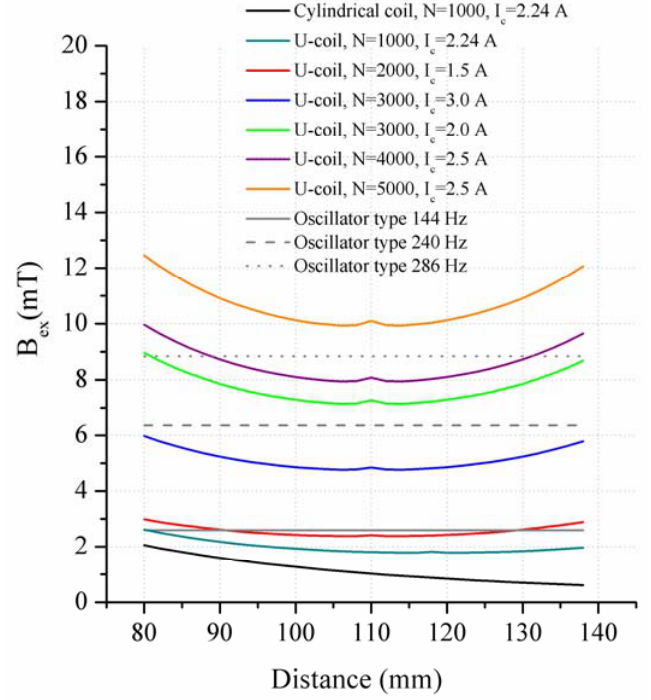
Figure 12. Comparison of the generated magnetic flux densities of the C-coil using different windings N and currents I in comparison with the calculated values of the c different oscillator types.